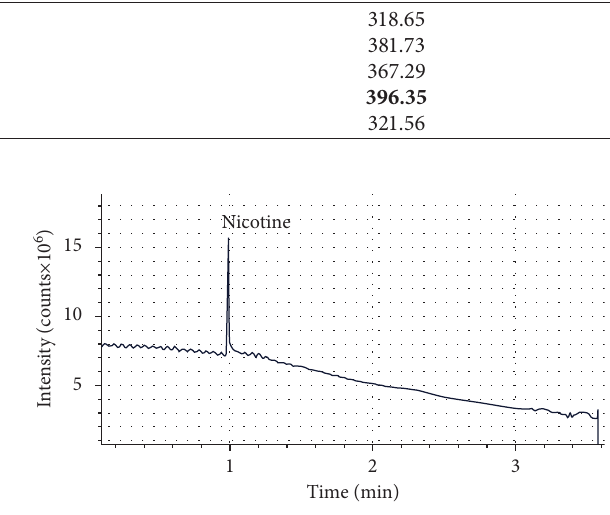
Figure 3: GC-MS scanned sample for qualitative